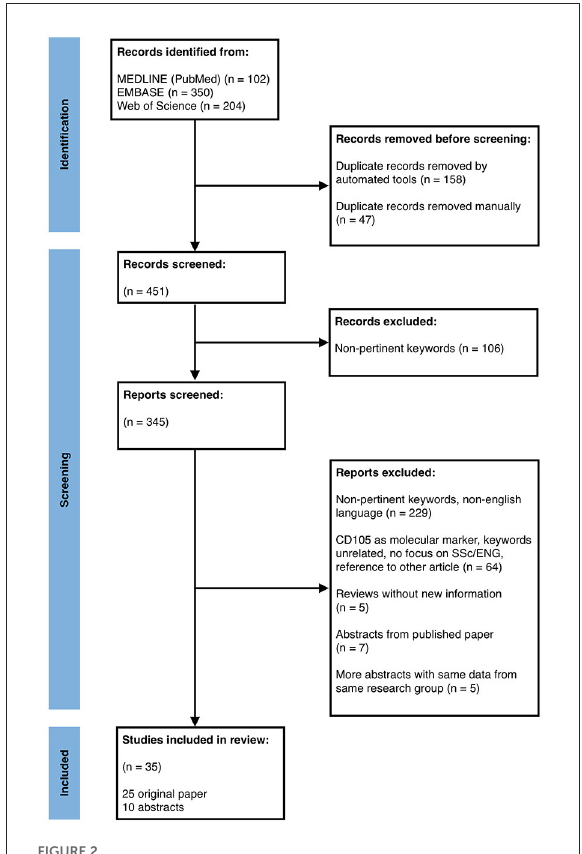
FIGURE2 PRISMA flow diagram depicting the different phases of records identification, inclusion and exclusion for the systematic review.